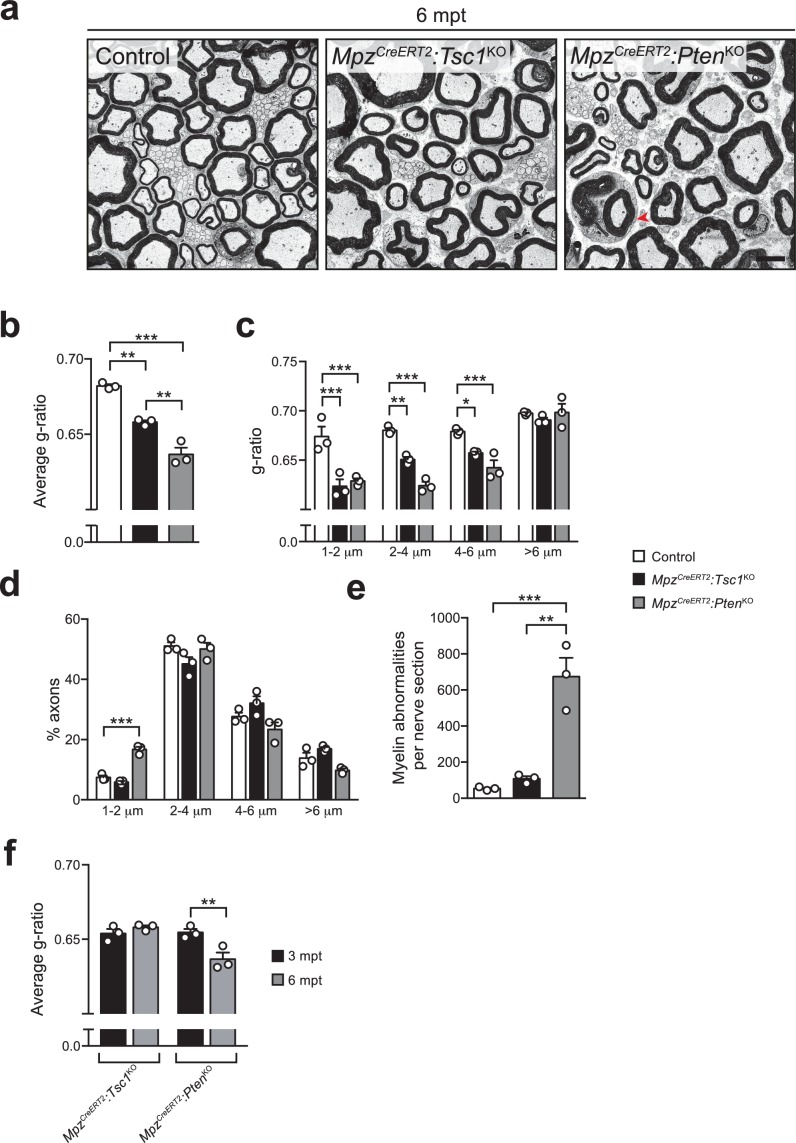
Radial hypermyelination in inducible knockout mice for TSC1 or PTEN is persistent at 6 mpt.(a) Electron micrographs of 6 mpt control, MpzCreERT2:Tsc1KO, and MpzCreERT2:PtenKO sciatic nerves (n = 3 mice/genotype). Arrowhead: myelin outfolding. Scale bar: 4 μm, refers to whole panel. (b–d) G-ratios, g-ratio distribution, and axon diameter distribution of 6 mpt sciatic nerves from control and mutant mice. At least 200 myelinated fibers per sample were analyzed (random EM fields). Bar height: mean; error bars: s.e.m. (n = 3 mice/genotype; b, one-way ANOVA with Tukey’s multiple comparisons test, F(2,6) = 67.33, p<0.0001, pcontrol vs TSC1KO = 0.0021, pcontrol vs PTENKO <0.0001, pTSC1KO vs PTENKO = 0.0038; c, two-way ANOVA with Tukey’s multiple comparisons test, F(6,24) = 7.359, p=0.0002, p1-2 μm control vs TSC1KO<0.0001, p1-2 μm control vs PTENKO <0.0001, p2-4 μm control vs TSC1KO = 0.0015, p2-4 μm control vs PTENKO <0.0001, p4-6 μm control vs TSC1KO = 0.0191, p4-6 μm control vs PTENKO = 0.0001; d, two-way ANOVA with Tukey’s multiple comparisons test, F(6,24) = 10.91, p<0.0001, p1-2 μm control vs PTENKO = 0.0007). (e) Myelin abnormalities per sciatic nerve cross section in 6 mpt controls and mutants. Bar height: mean; error bars: s.e.m. (n = 3 mice/genotype, one-way ANOVA with Tukey’s multiple comparisons test, F(2,6) = 31.83, p=0.0006; pcontrol vs PTENKO = 0.0009, pTSC1KO vs PTENKO = 0.0014). (f) Comparison between average g-ratios of MpzCreERT2:Tsc1KO and MpzCreERT2:PtenKO mice at 3 and 6 mpt. Bar height: mean; error bars: s.e.m. (n = 3 mice/genotype, two-way ANOVA with Sidak’s multiple comparisons test, F(1,8) = 13.6, p=0.0062; pPTENKO 3 mpt vs 6 mpt = 0.0057). *p<0.05, **p<0.01, ***p<0.001.